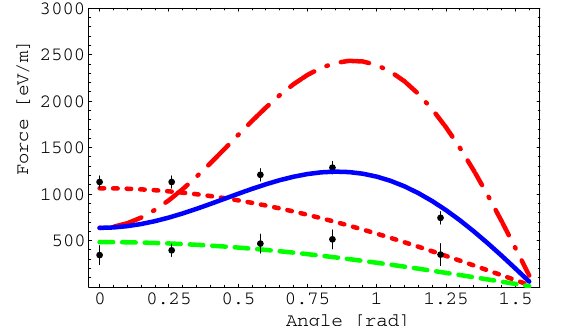
FIG. 4. (Color) Longitudinal component of the force: (1) For (cid:5) 4 : 2 (cid:6) 10 5 m = s : red (dot-dashed) line—Eq. (5); red (cid:1) e; ? short-dashed line—Eq. (9); dots with error bars— VORPAL re- (cid:5) 1 : 1 (cid:6) 10 7 m = s : blue solid line—Eq. (5); sults. (2) For (cid:1) e; ? green long-dashed line—Eq. (9); open circles with error bars— VORPAL .